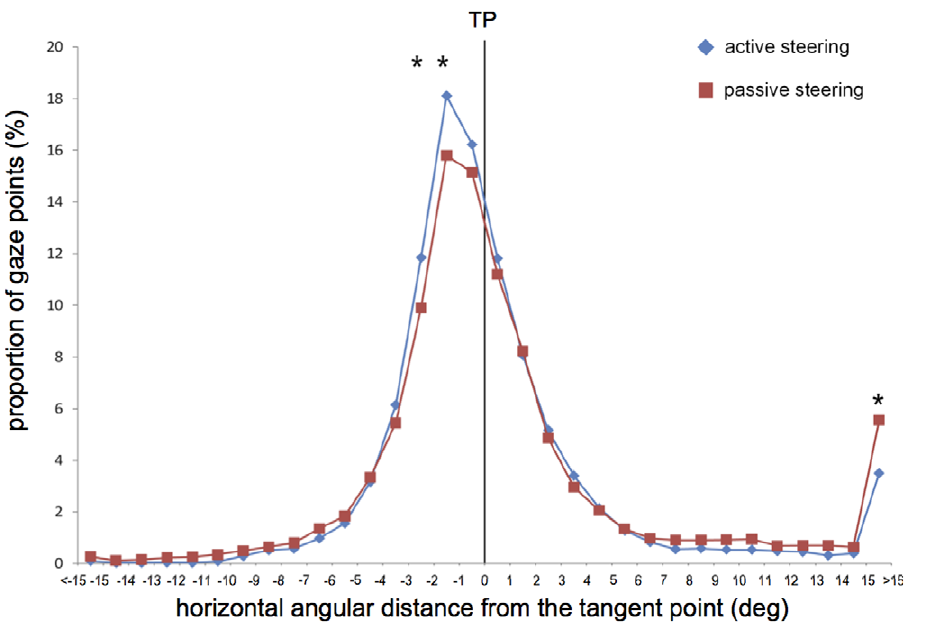
Figure 2. Distribution of gaze points as a function of horizontal angular deviation from the tangent point. A positive value on the x axis represents a gaze deviation in the direction of the bend exit (to the left for left bends, to the right for right bends). Asterisks indicate significant differences between active and passive conditions.